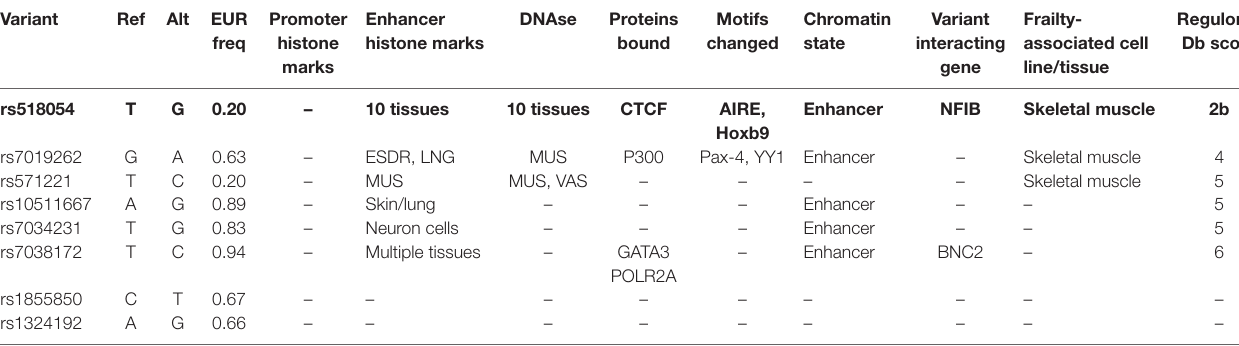
Table 4 | Details of putative regulatory functions of associated lead SNPs. Variant